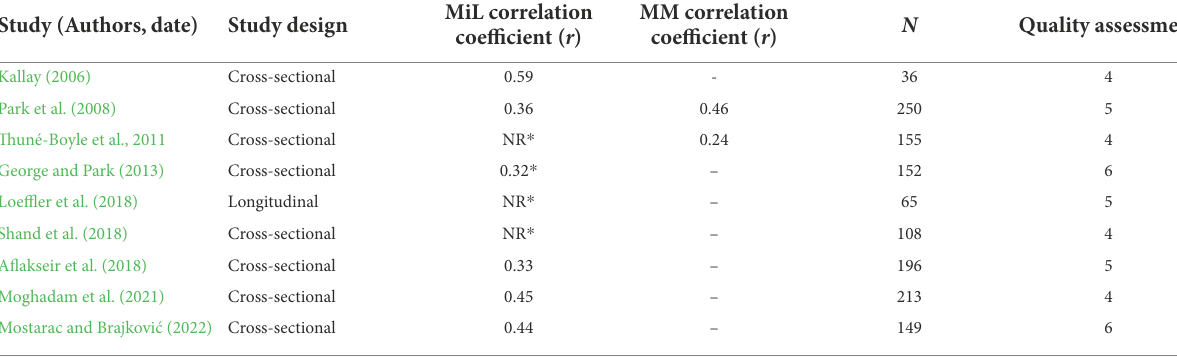
TABLE 2 Meaning in life and meaning-making correlations to posttraumatic